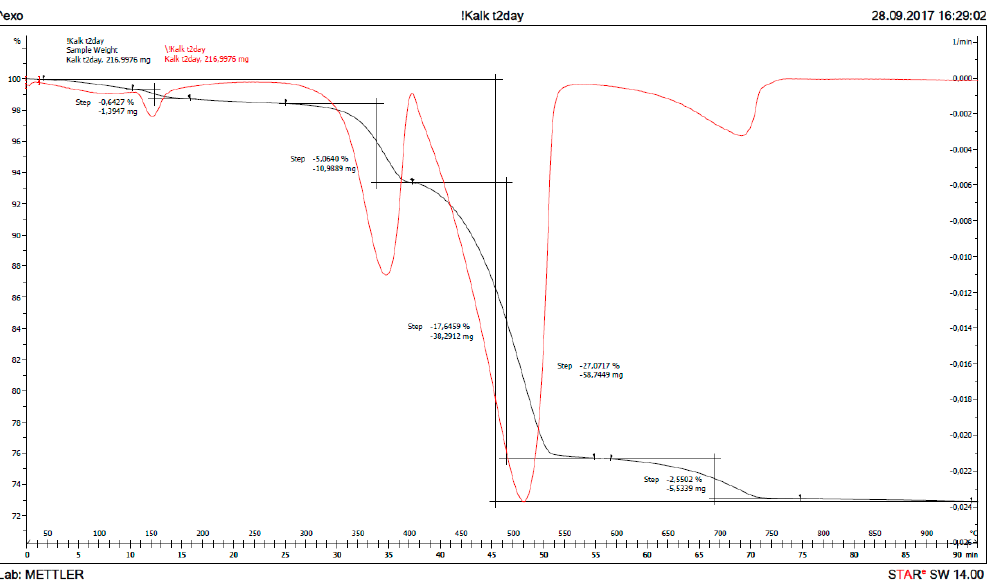
Figure 12. The thermogravimetry curves (TG) in black and its derivative (DTG) in red for fine CaO as received.